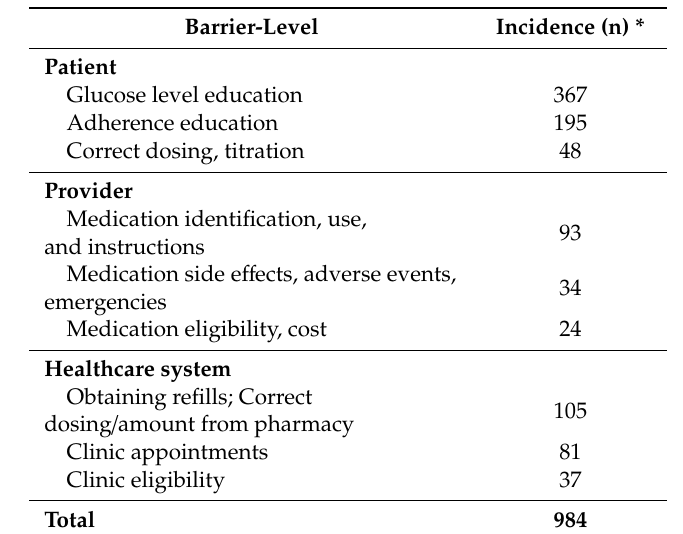
Table 3. Community Health Worker–participant weekly telehealth report data, stratified into patient-, provider-, and healthcare-system-level barriers